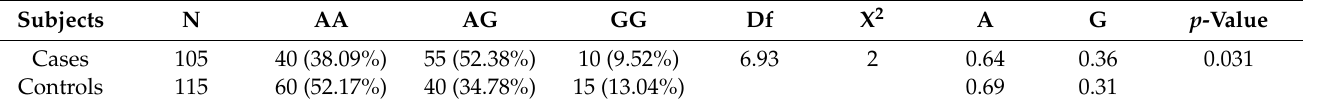
Table 5. Association of miR-27a rs895819 A > G gene variation in PCOS cases and controls.